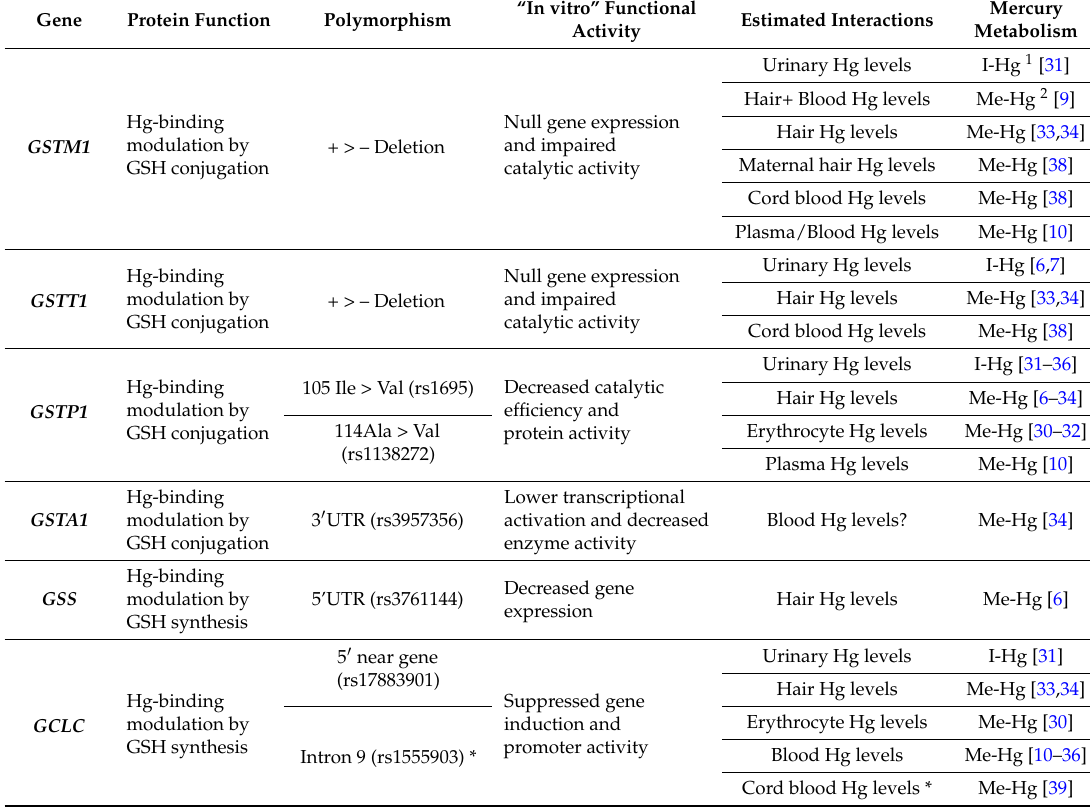
Table 2. Relevant genes and their potential role for mercury toxicokinetics, with the most recognized markers of susceptibility to mercury